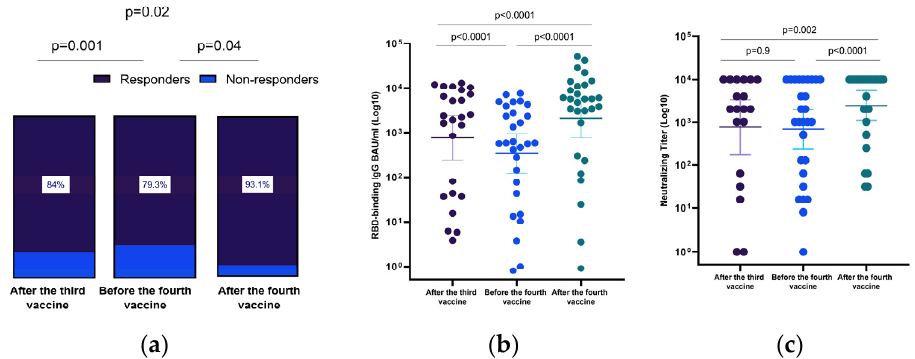
Figure 2. Changes in the humoral immune response after the third and the fourth vaccine doses among liver transplant recipients. ( a ) Changes in immune response after the third and fourth doses among the 29 liver transplant recipients who had paired serology samples. ( b ) Scatter plot presenting changes in anti-RBD IgG and ( c ) SARS-CoV-2 pseudo-virus neutralizing antibody titers after the third and the fourth vaccine dose (after the third vaccine test, serum collection was 22 days (IQR, 21–28 days), after the third vaccine and before the fourth vaccine test, it was 131 days (IQR, 129–137 days), and after the third dose and after the fourth vaccine test, it was 29 days (IQR, 25–33 days) after administration of the fourth vaccine dose). Differences in paired samples were calculated using the Wilcoxon matched-pairs signed-rank test. The horizontal line indicates geometric mean values with a 95% confidence interval. Table 3. Immune response before and after the fourth BNT162b2 mRNA vaccine compared to immune response immediately after the third